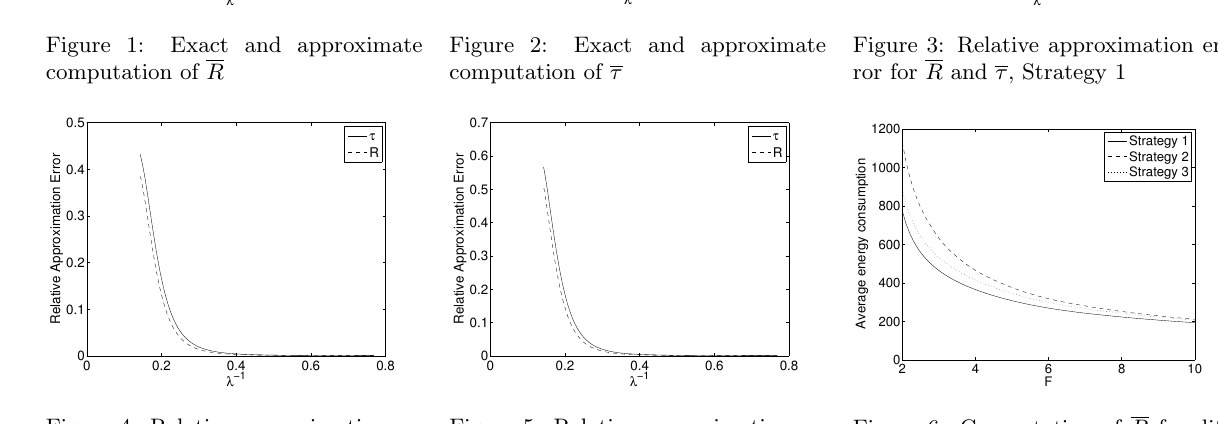
Figure 6: Computation of R for dif- ferent strategies